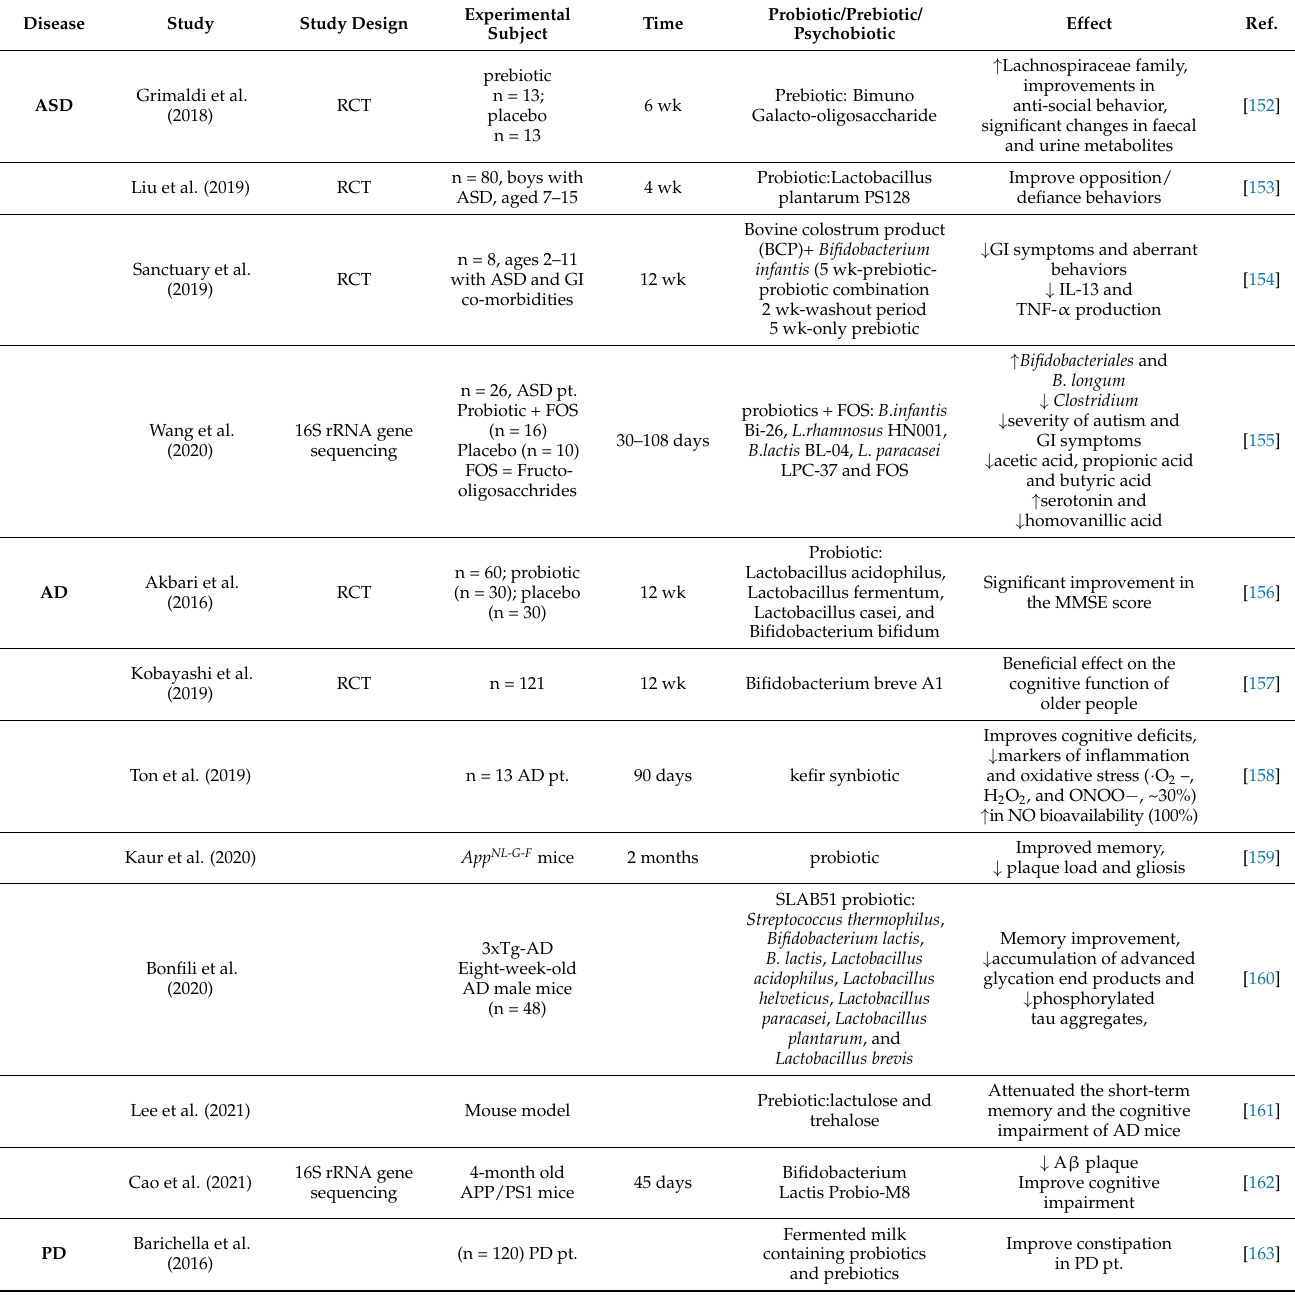
Table 2. Effect of pre-biotics and probiotics on various neurological